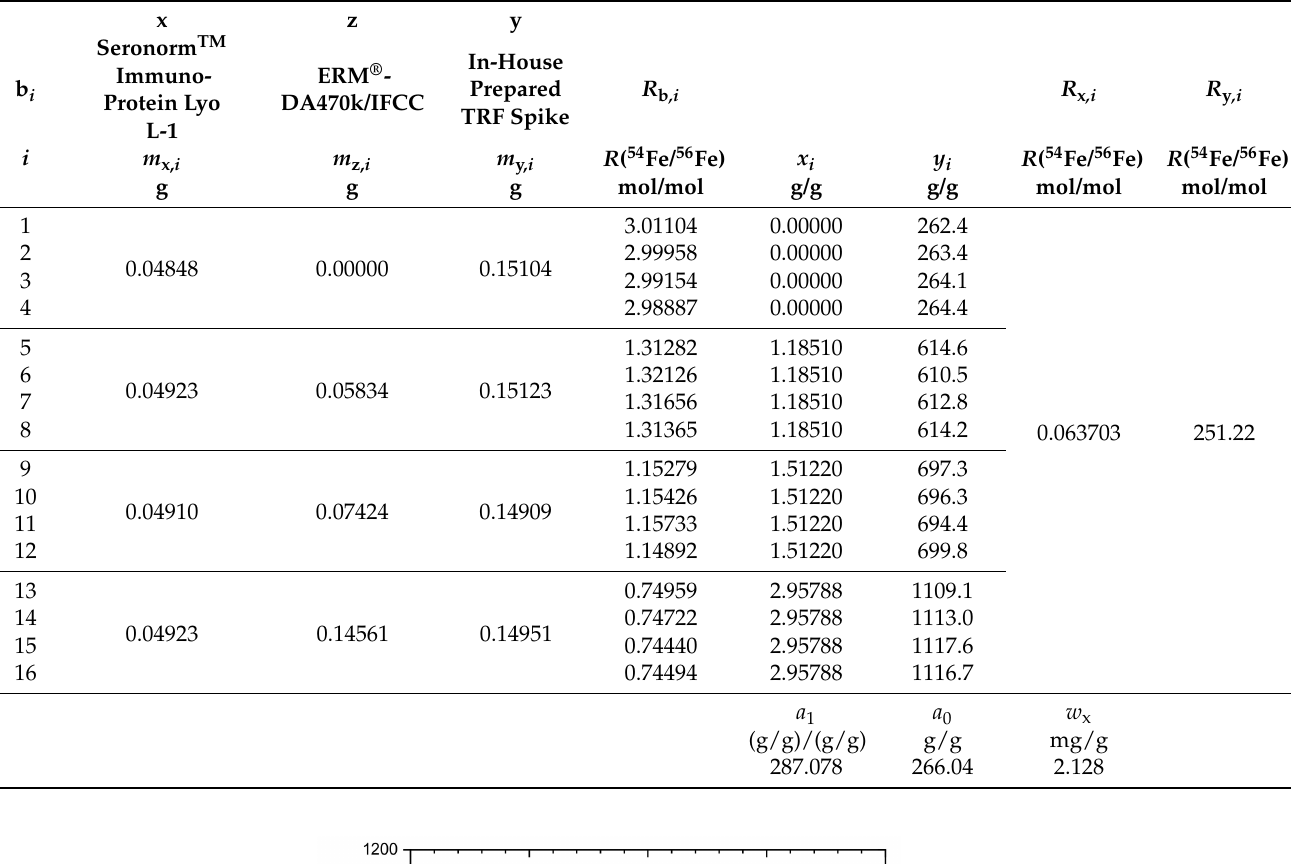
Table 6. Determination of w x (TRF) in human serum. The relevant input and output data of linear regression analysis are given for a single representative dataset (M21-3), with w z = 2.296 mg/g.